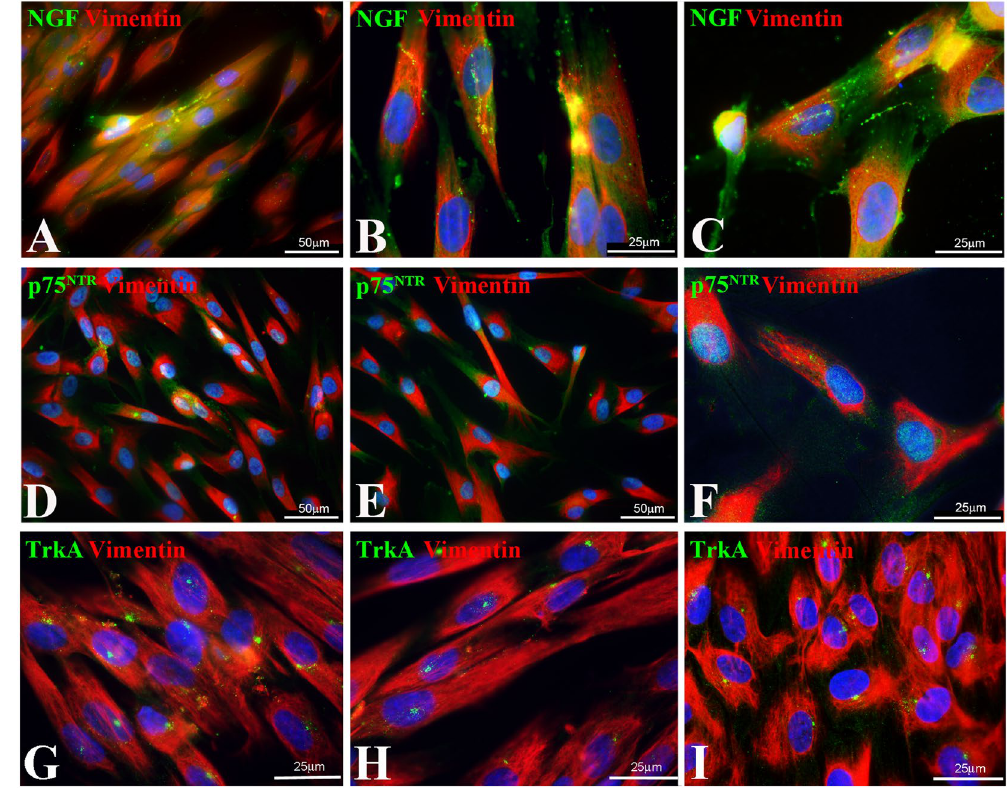
Figure 4. Expression of NGF, p75 NTR and TrkA in combination with vimentin in human dental pulp stem